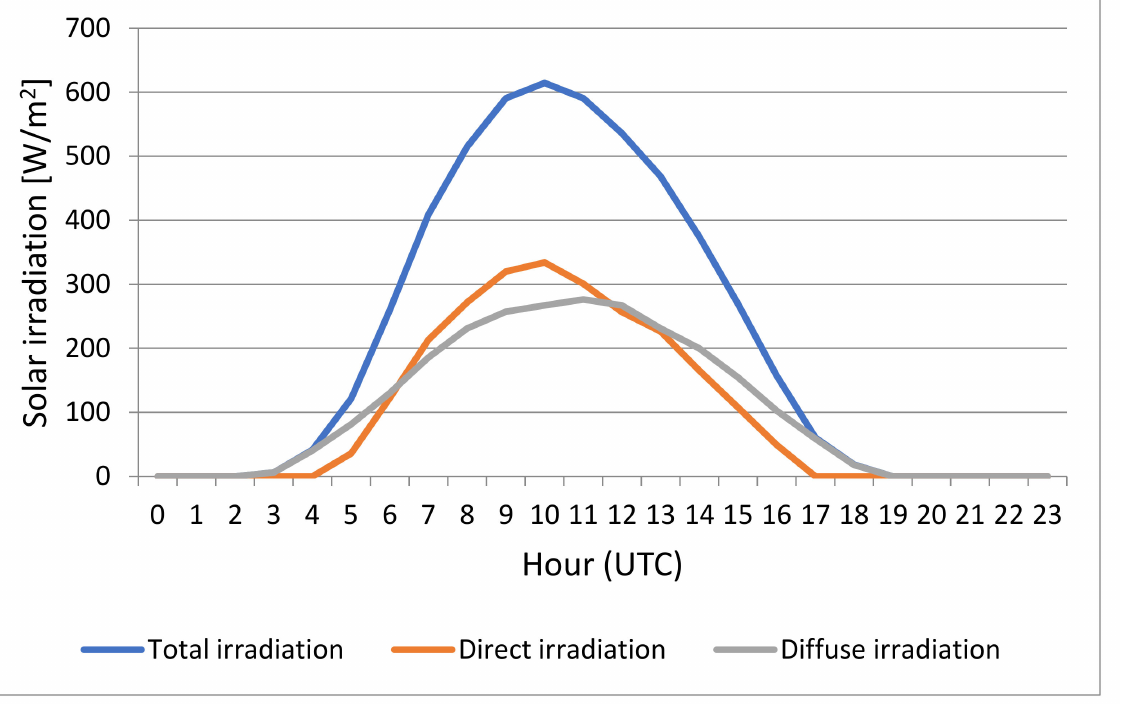
Figure 2. The value of solar radiation falling on the collector on a selected day in June in Katowice.